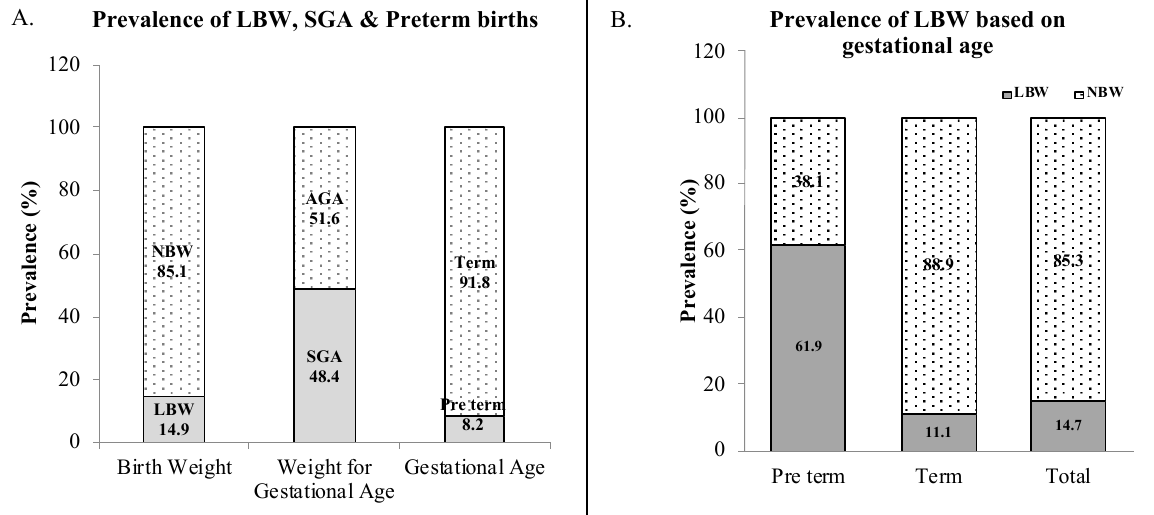
Figure 2. ( A ) Prevalence of low birth weight (LBW, <2.5 kg), small for gestational age (SGA, children in <10th percentile weight category for the gestational period) and preterm birth in the cohort pop- ulation; ( B ) Prevalence of LBW among preterm (<37 weeks) and term newborn (n = 593).